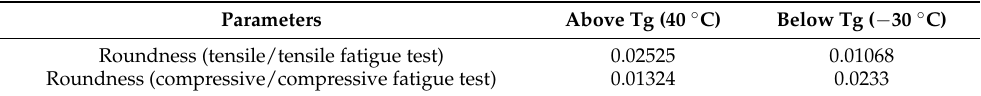
Table 2. Roundness of untreated and cryo-treated CFRP specimens.